Question: Which kind of chart has been used to present this data?
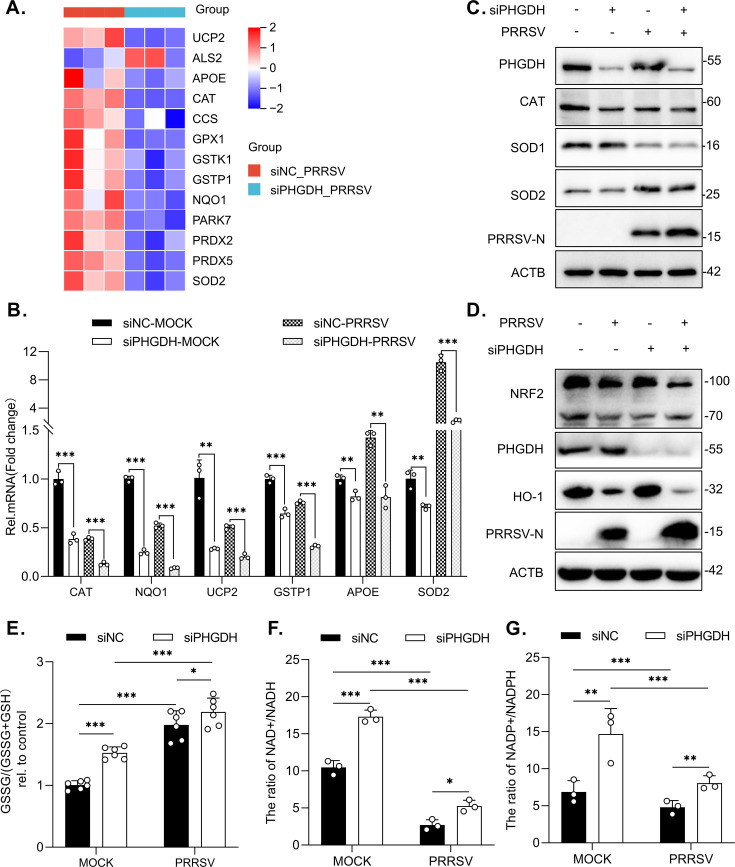
Answer: heatmap